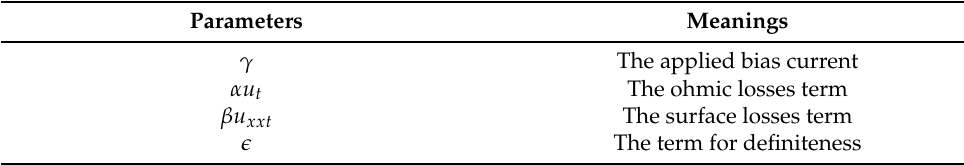
Table 1. Meanings of parameters. Parameters Meanings γ The applied bias current α u t The ohmic losses term β u xxt The surface losses term (cid:101) The term for